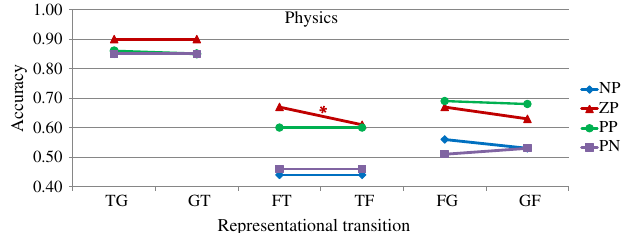
FIG. 4. Data from the 3-way interaction effect of representa- tional transition (TG, GT, FT, TF, FG and GF), function type (NP, ZP, PP, and PN) and context for the context of physics. The data points connected by lines represent the pairs of transitions which are each other ’ s opposite. The p value of the comparisons is indicated by * for p < 0 . 05 , ** for p < 0 . 01 , *** for p < 0 . 001 . There is a significant ( p < 0 . 05 ) asymmetry for the ZP function type between FT and TF transitions in the physics context.